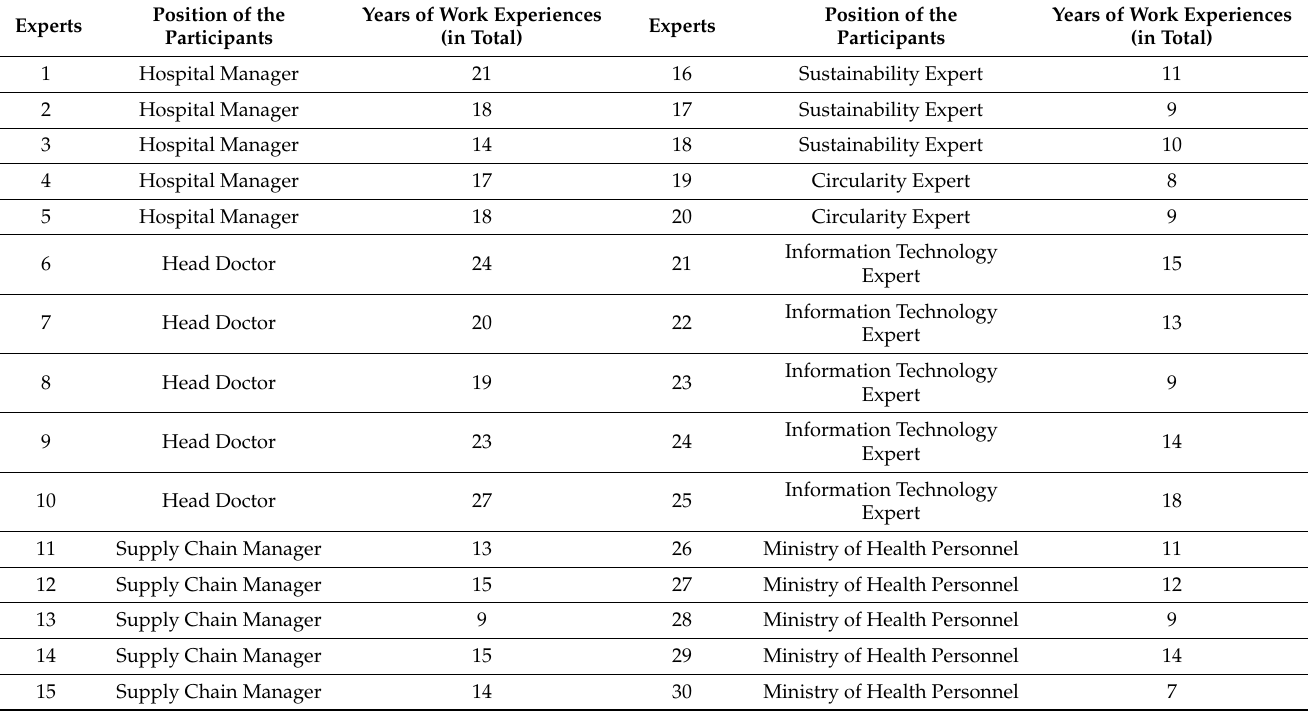
Table 2. Information about